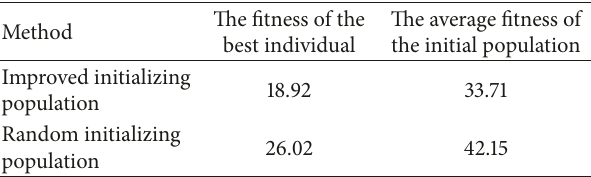
Figure 8: Mutation operation for machine part.